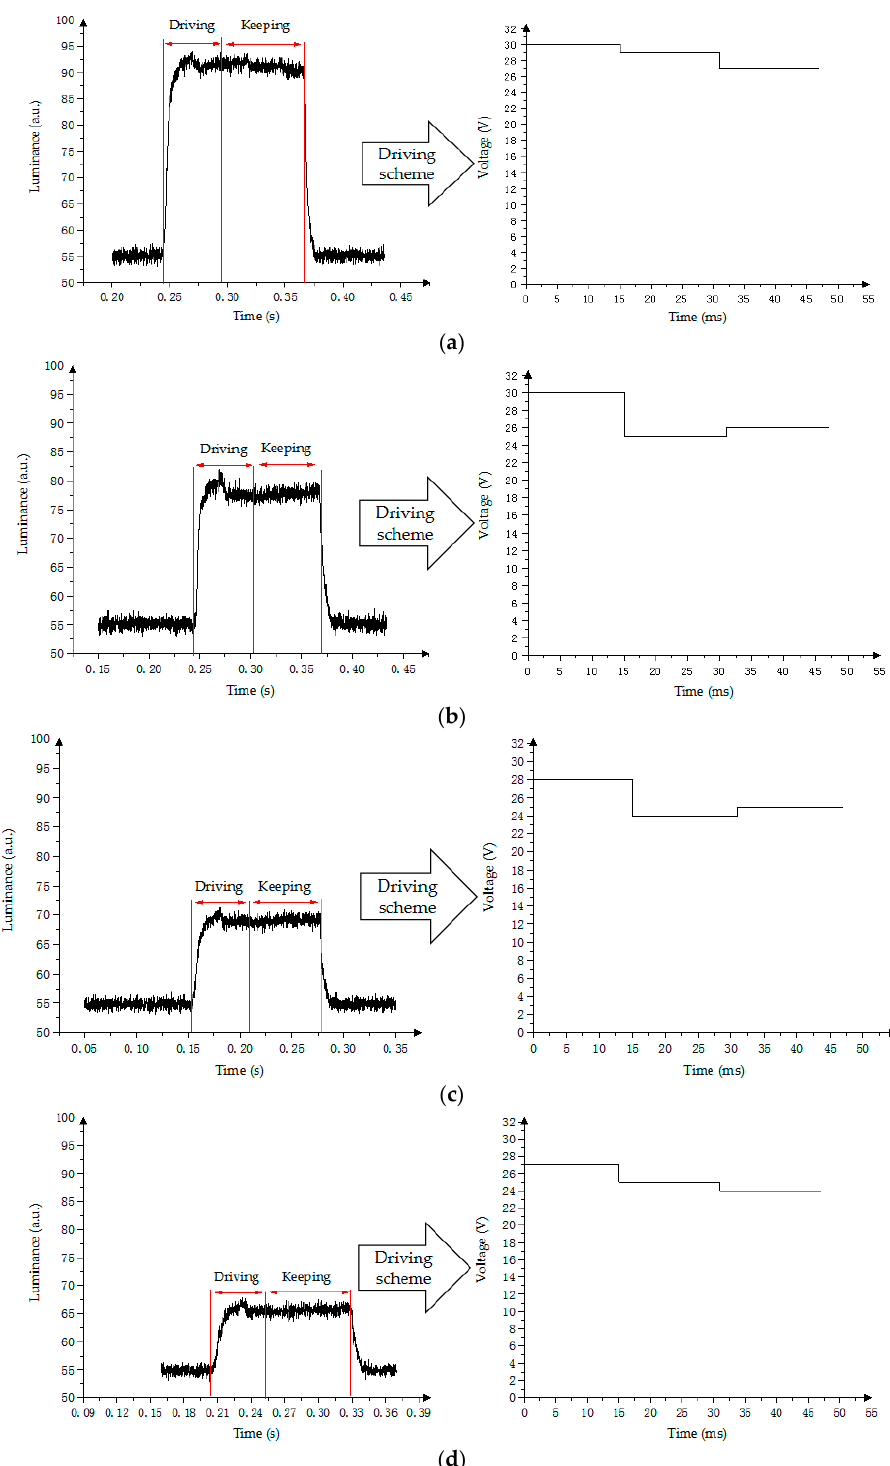
Figure 9. Amplitude – frequency mixed modulation waveform and its luminance response. ( a ) First Figure 9. Amplitude–frequency mixed modulation waveform and its luminance response. ( a ) First gray scale; ( b ) Second gray scale; ( c ) Third gray scale; ( d ) Fourth gray scale. gray scale; ( b ) Second gray scale; ( c ) Third gray scale; ( d ) Fourth gray